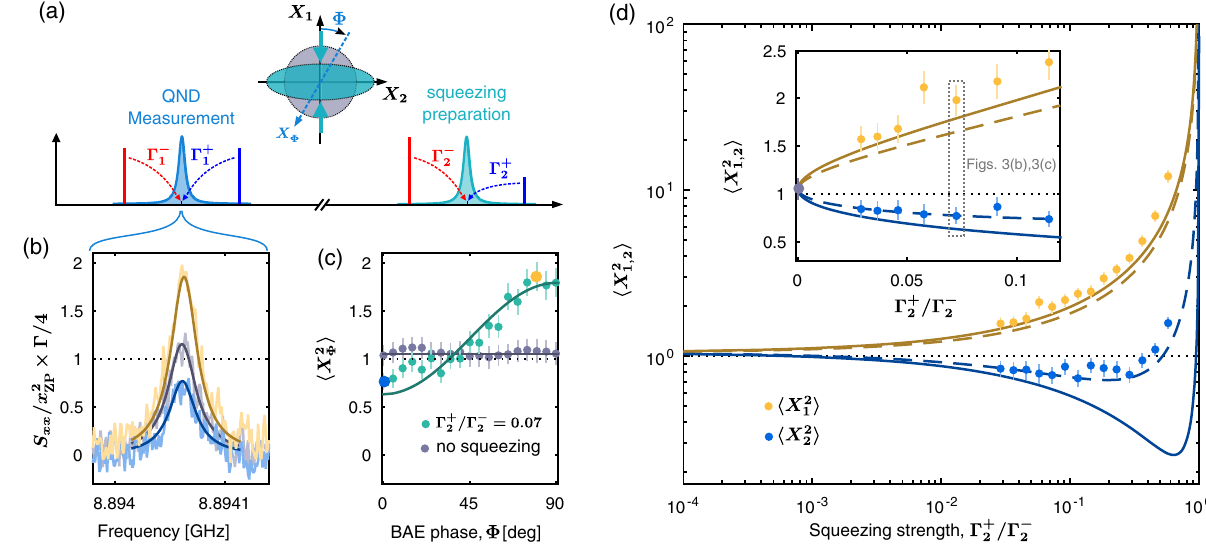
FIG. 3. Tomography of a mechanical squeezed state. (a) Measurement schematic. A pair of drives at ω (cid:1) 2 ¼ ω 2 (cid:1) Ω cools the m ˆ X mechanical mode to a squeezed bath, while a pair of drives at ω (cid:1) 1 ¼ ω 1 (cid:1) Ω measures the generalized mechanical quadrature Φ , given m by the tunable phase Φ , allowing for the tomographic measurement of the squeezed state. (b) Normalized noise spectra of the QND measurement (background subtracted), for the squeezed and antisqueezed quadratures ( Γ − 2 = Γ þ 2 ¼ 0 . 07 ) in blue and yellow, respectively, compared to a spectrum measured without squeezing ( Γ þ 2 ¼ 0 ) in gray. (c) Measured quadrature variances as a function of phase for Γ þ ¼ 0 in gray and Γ − Γ þ ¼ 0 . 07 in green. The spectra in (b) correspond to the blue and yellow dots. (d) Squeezed and antisqueezed 2 = 2 2 quadrature variances, respectively, in blue and yellow, as a function of the squeezing strength Γ − 2 = Γ þ 2 . The solid lines are the theoretical predictions with no free parameters. The dashed lines are the theoretical predictions including a drift of the measurement phase of 35 deg during the acquisition of each spectrum (see Appendix E). The inset is a zoom-in for the low squeezing strength data, on a linear scale, where we can place the variance measured without squeezing (gray dot). In all figures, the black dotted line is the vacuum